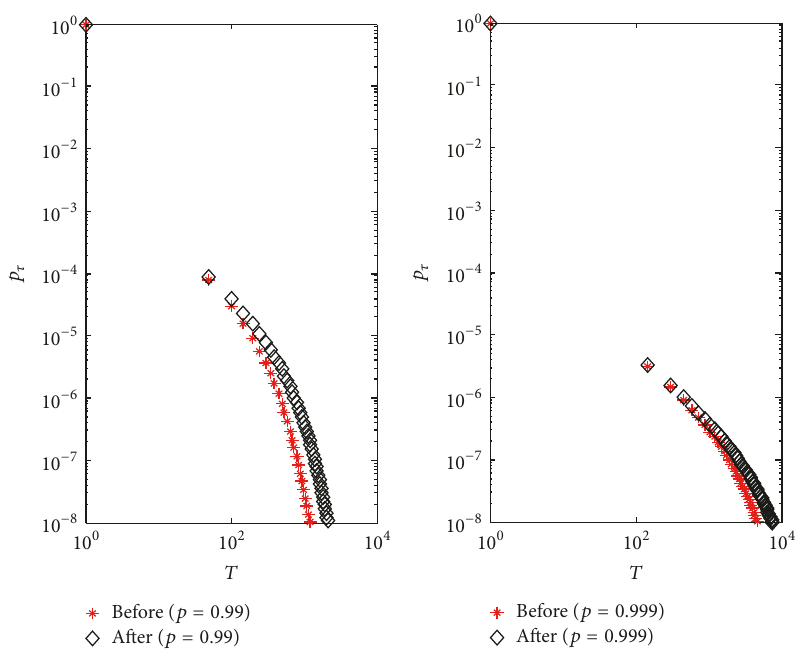
Figure 7: Favorable event waiting time probability distribution comparison chart ( 𝑝 = 0.99/0.999